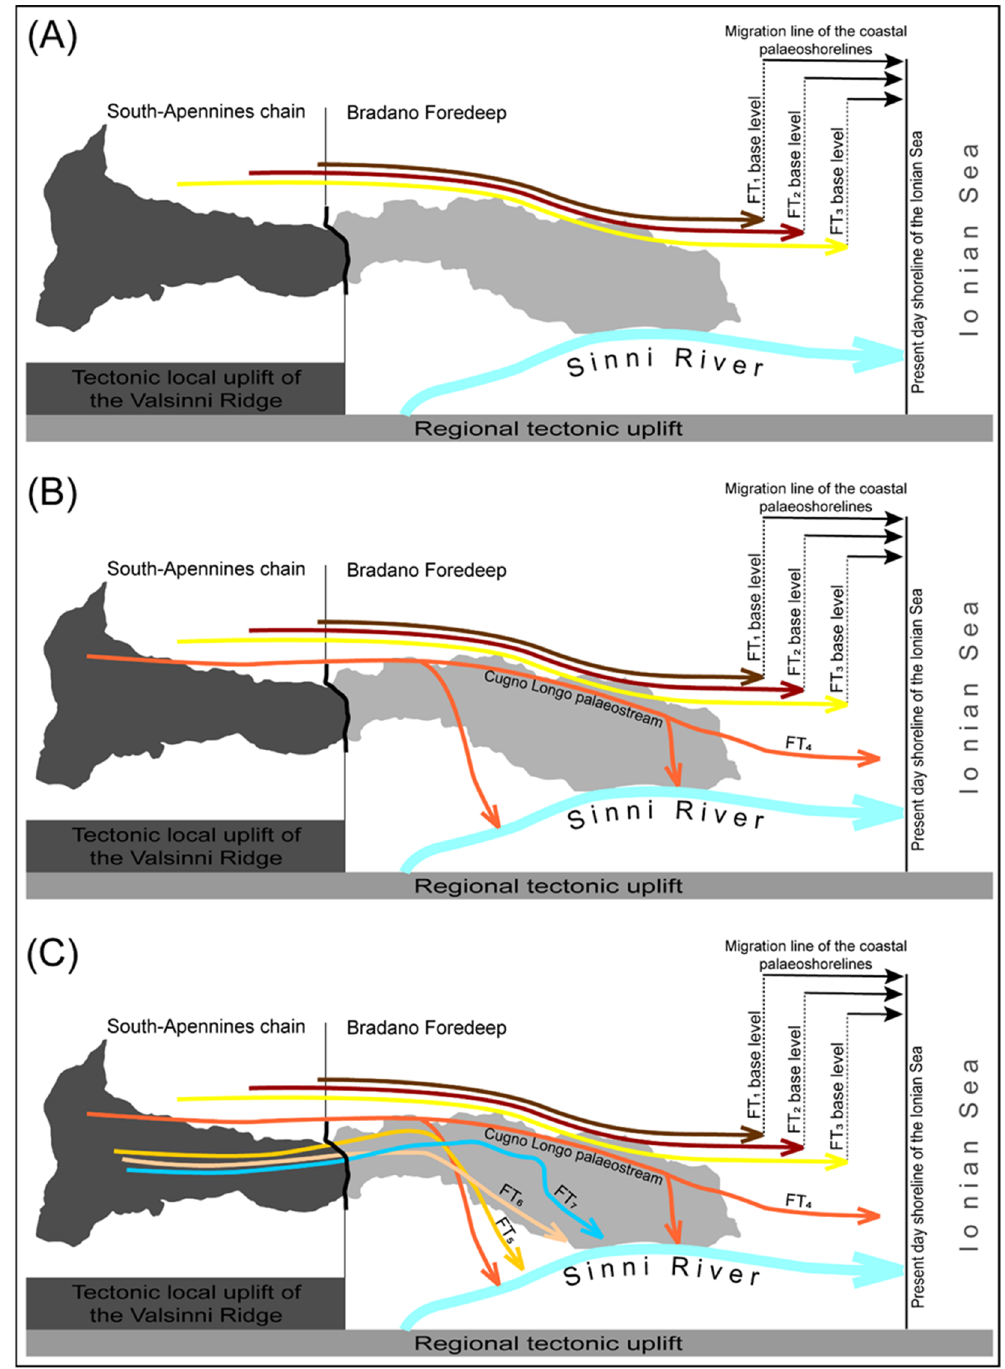
Figure 15. Sketch map of the three evolutionary stages ( A , B , and C ) in the formation and evolution of the fluvial terraces in the Pescogrosso drainage basin and surrounding areas. See text for explanation.